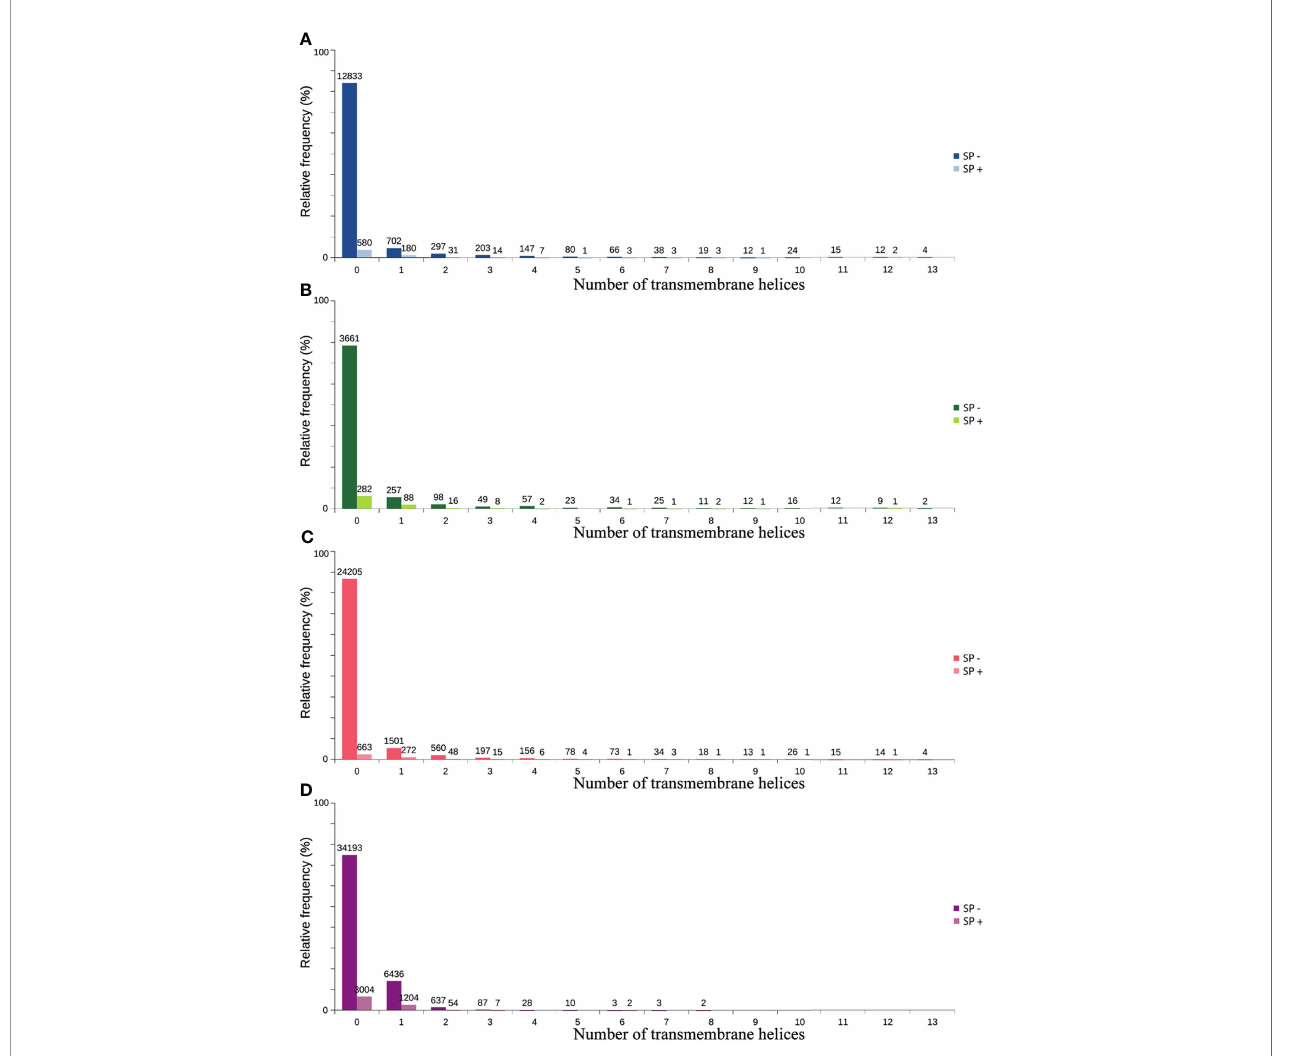
FIGURE 4 | Predicted distribution of ORFs according to the number of transmembrane helices (TMHMM) and the presence of signal peptide (SP+ or SP-). (A) TransDecoder 15270 (20.7%). (B) Augustus 4668 (6.3%). (C) ORF fi nder (Matched ORF) 27910 (37.9%). (D) ORF fi nder (Unmatched ORF) 45670